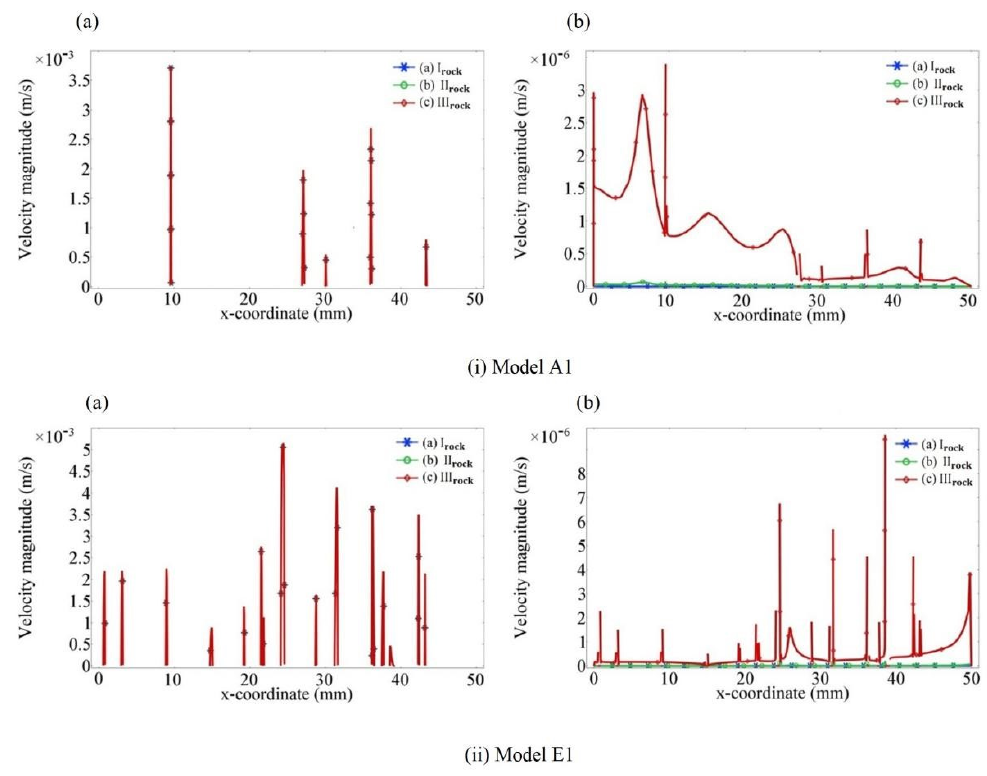
Figure 9. Fracture flow velocity ( a ) and matrix flow velocity ( b ) values at the outlets of the model A1 (i) and model E1 (ii).